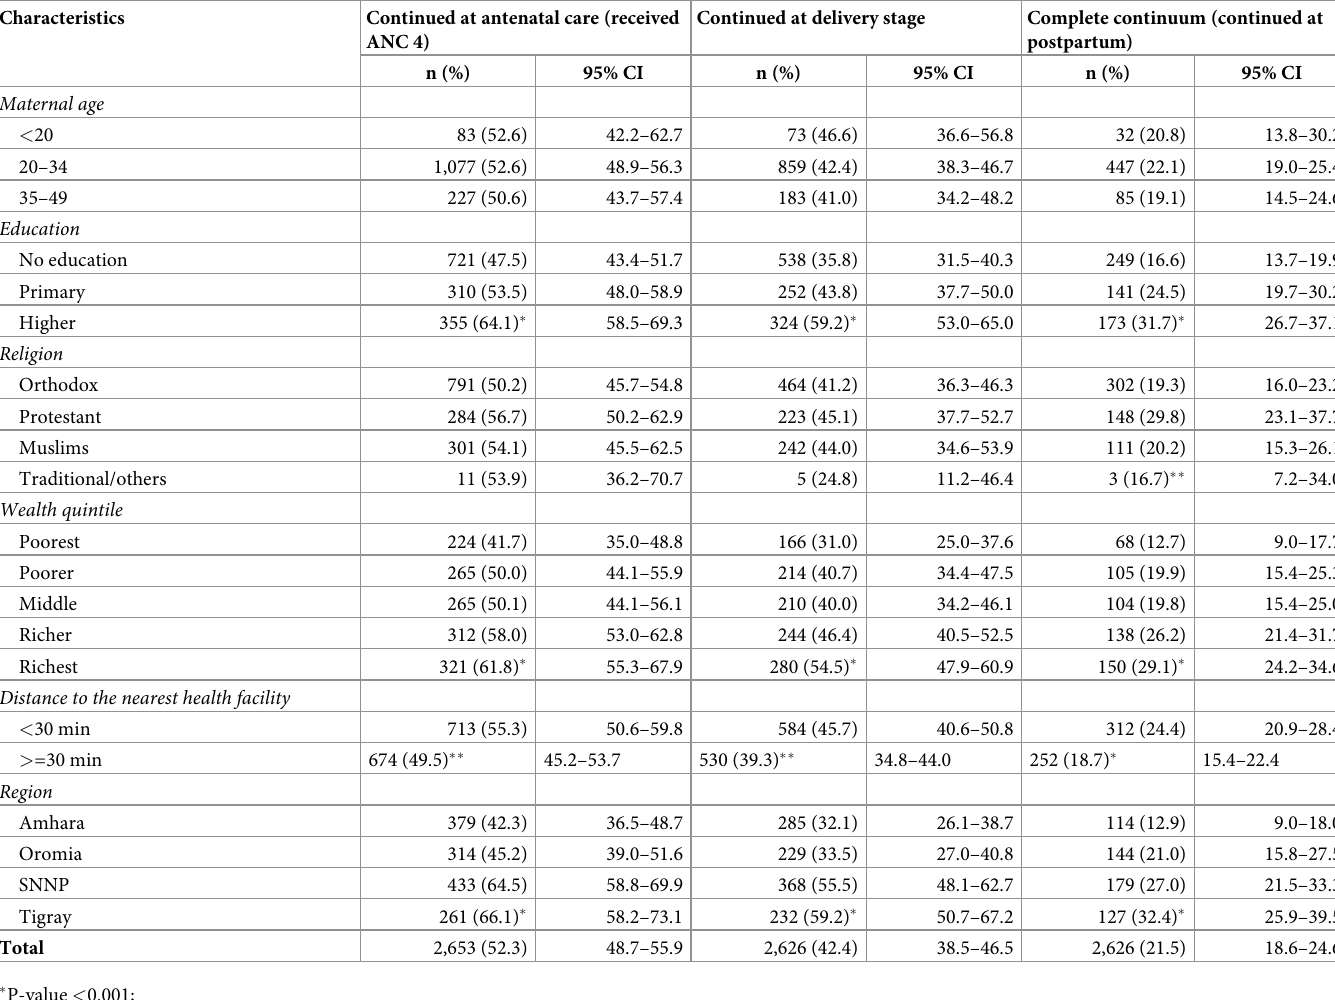
Table 3. Distribution of maternal health services across the CoC in Ethiopia, by sociodemographic characteristics, 2017.